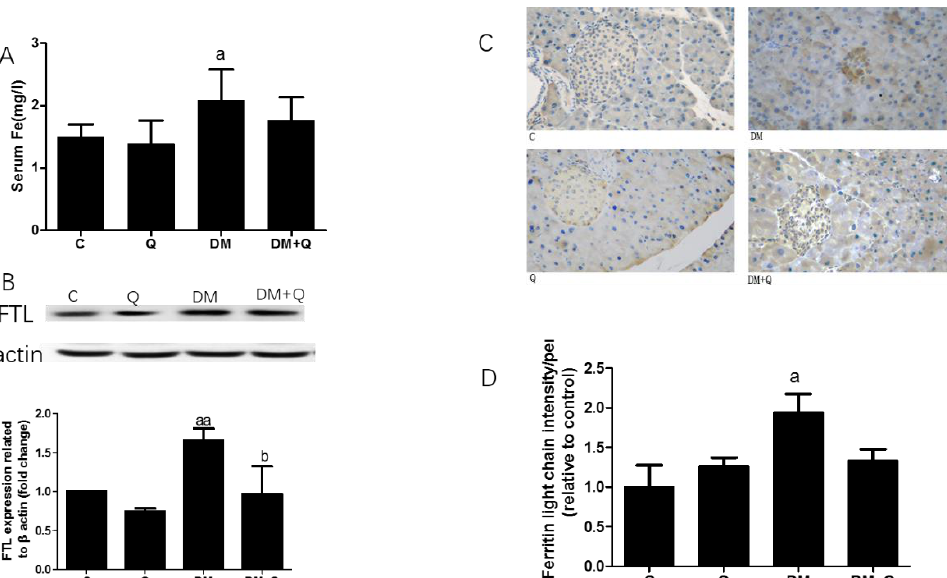
Figure 4. E ff ect of quercetin on iron levels in the pancreas of mice. ( A ). Serum iron level was measured by colorimetric kit according to the manufacturer’s instructions (mg / L) ( n = 10); ( B ). Western blot analysis was performed to measure ferritin light chain (FTL) and quantified by Image-Pro Plus 6.0 software. Blotting with β -actin was used as a protein loading control ( n = 3); ( C ). Representative images of pancreatic sections immunohistochemically stained for the ferritin light chain. (dark brown) ( n = 3). (image magnification: 400 × ); ( D ). Quantification of the ferritin light chain level in islets detected by immunohistochemically staining in pancreatic tissue ( n = 3). Data were expressed as mean ± SD. (a: p < 0.05 vs. C; aa: p < 0.01 vs. C; b: p < 0.05 vs.